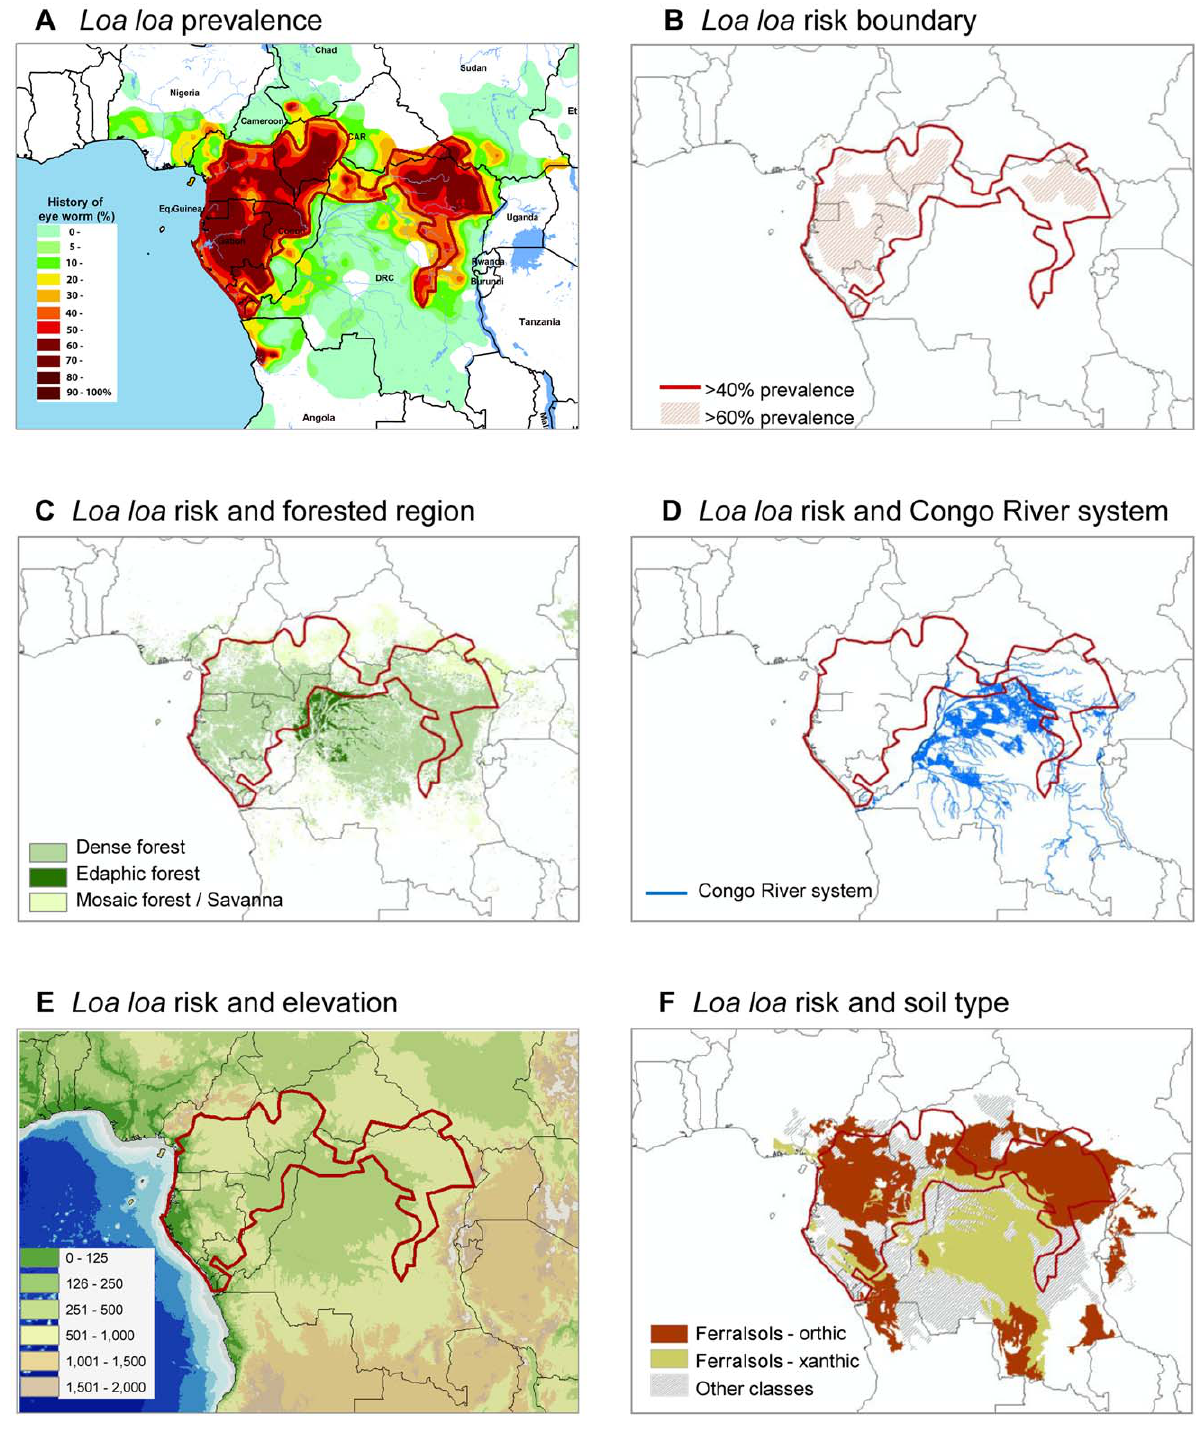
Figure 1. L.loa prevalence and risk in relation to topographical and ecological factors. (A, B) The loiasis map published by Zoure´ et al. [3] was imported into ArcGIS 9.3 (ESRI, Redlands, CA), and the high ( . 40%) and very high ( . 60%) prevalence areas digitised based on interpolated boundaries. (C, D, E, F) The relationship between disease risk and dense tropical forests, the Congo River and its tributaries, elevation, and soil type was examined using geo-referenced maps and data